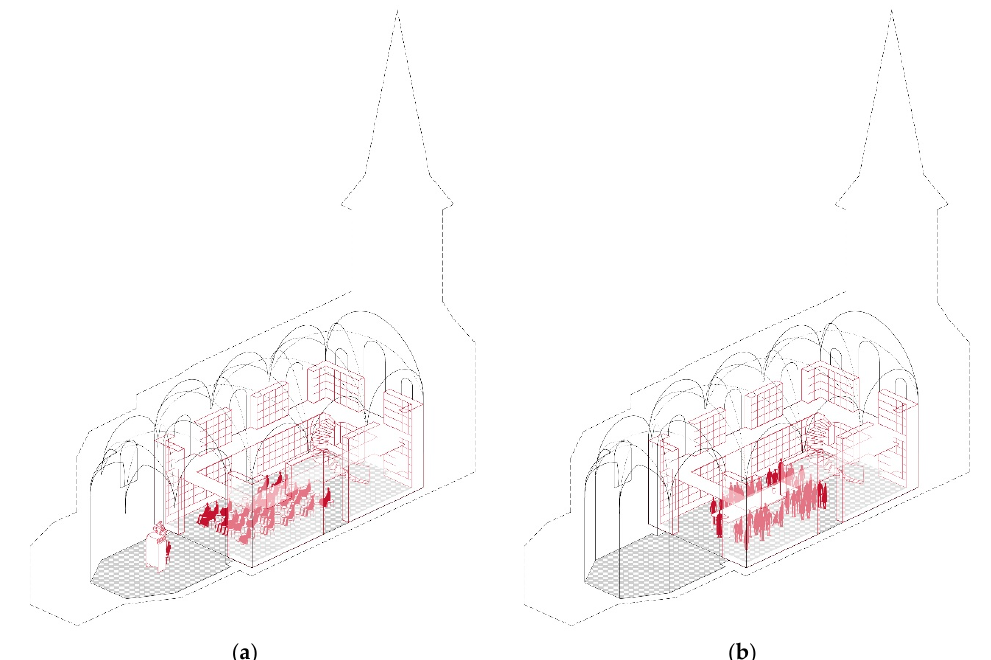
Figure 5. Columbarium church of St. Odulphus, axonometric view of the interior of the nave and apse and the its use: ( a ) Traditional set-up, allowing for di ff erent activities: memorial gatherings, small concerts, etc.; ( b ) Set-up defined by the central presence of a table, confirming the intimate setting and symbolizing (Christian) gathering.